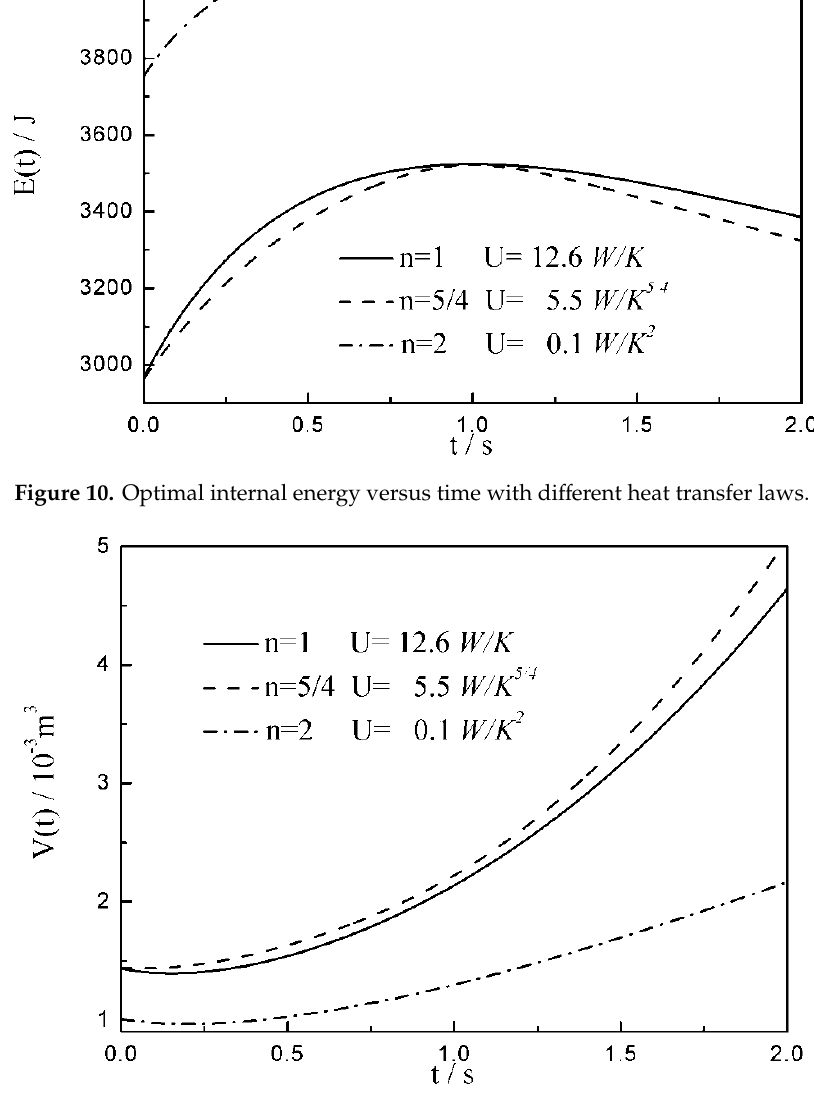
ff erent heat transfer Figure 11. Optimal volume versus time with different heat transfer laws. Figure 11. Optimal volume versus time with di Figure 11. Optimal volume versus time with different heat transfer laws.